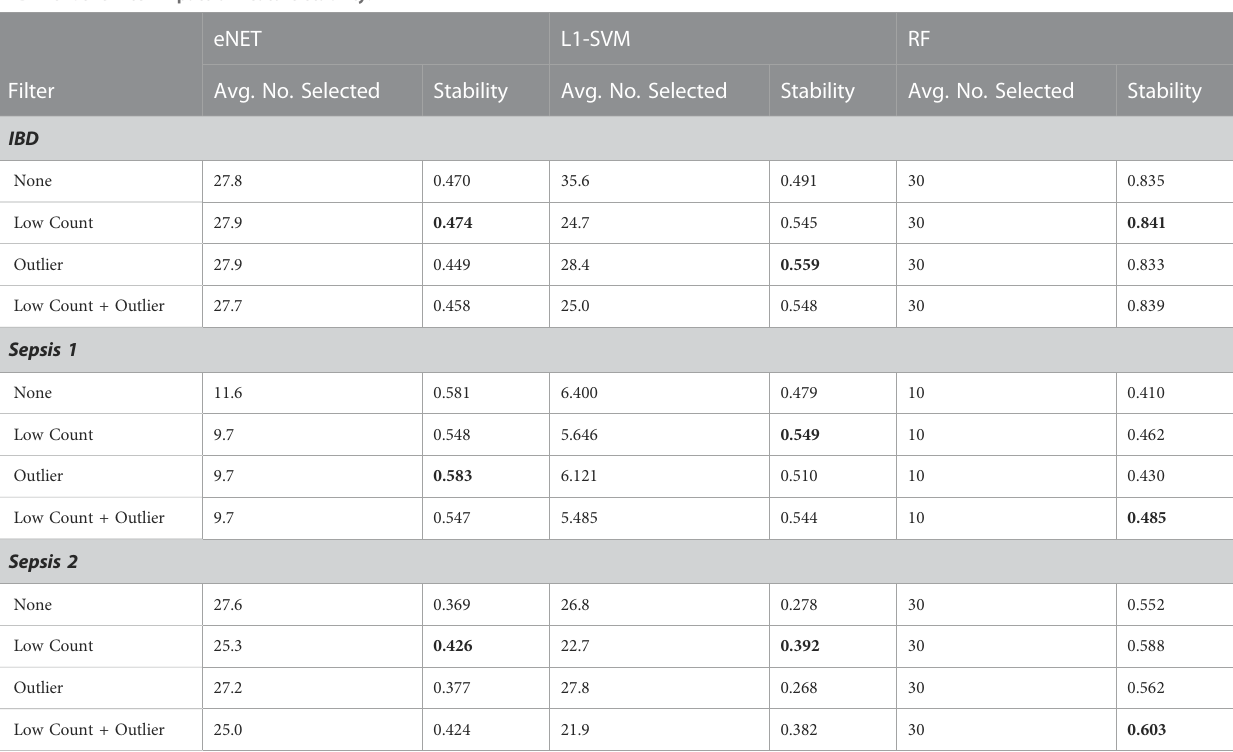
The bold values are the highest scoring fi lter for each